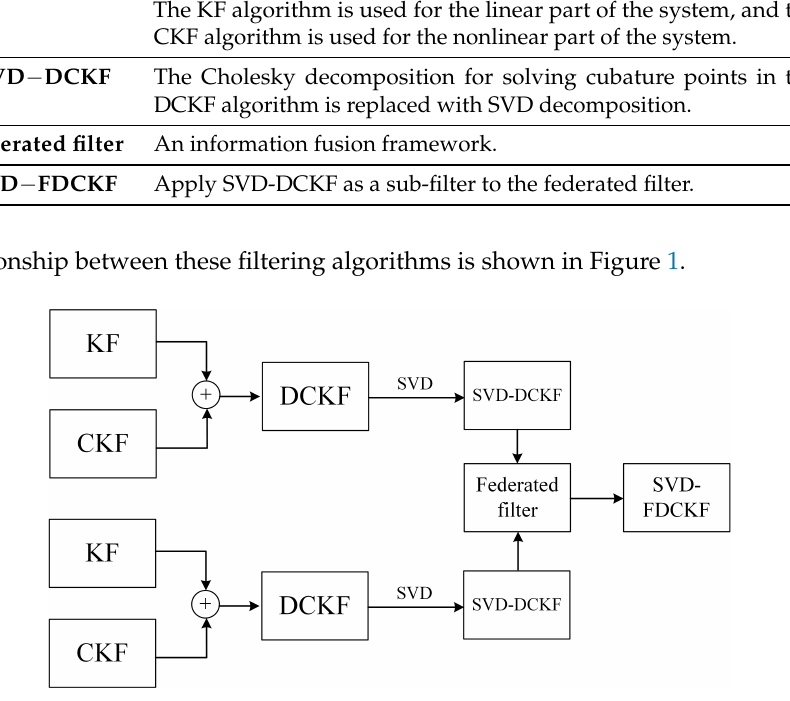
Figure 1. Relationship between filtering